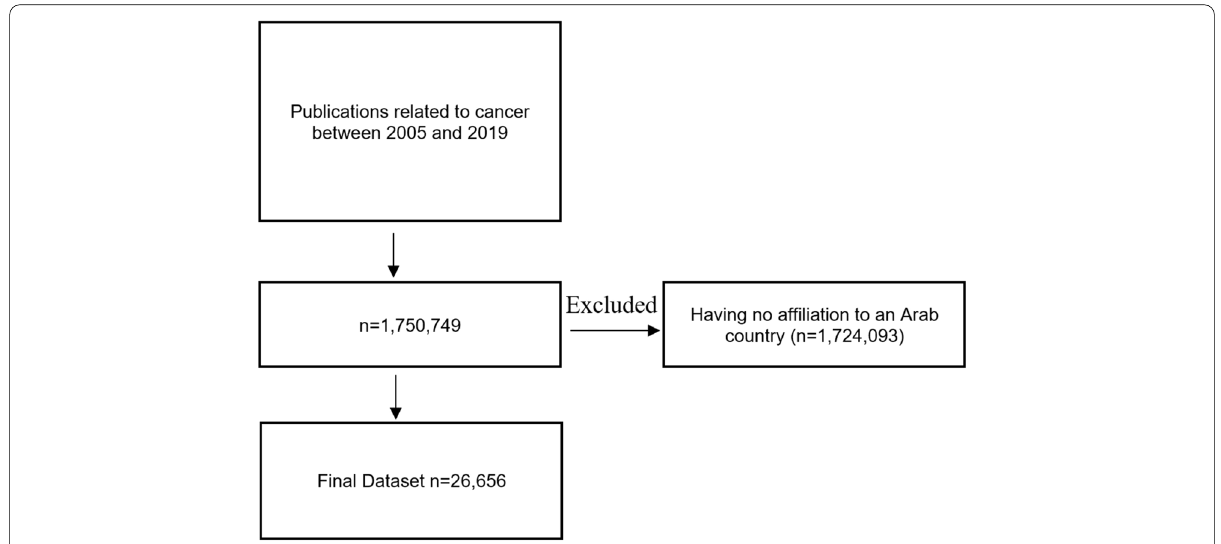
Fig. 1 Identification and selection of publications related to